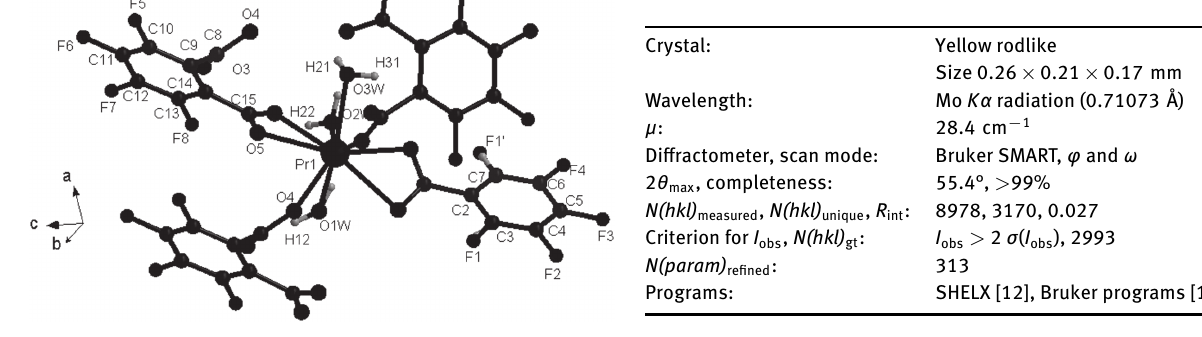
Table 1: Data collection and handling.